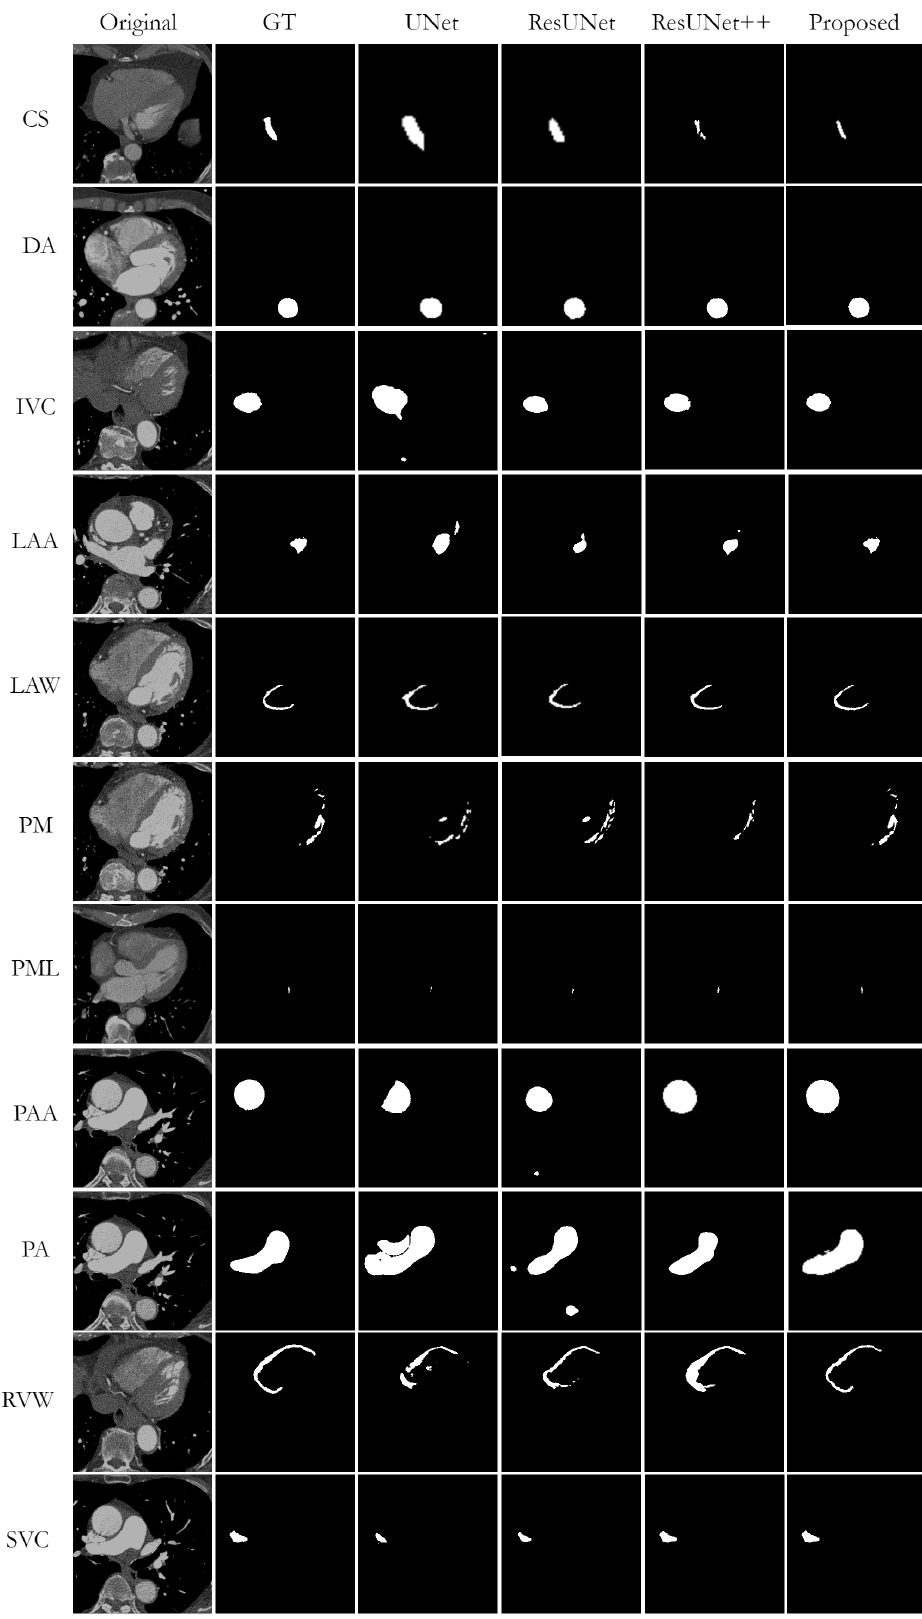
Figure 5. Qualitative results comparison of the different cardiac structures. Rows from left to the right represent original image, ground truth, UNet results, ResUNet results, ResUNet++ results, and AB-ResUNet+,